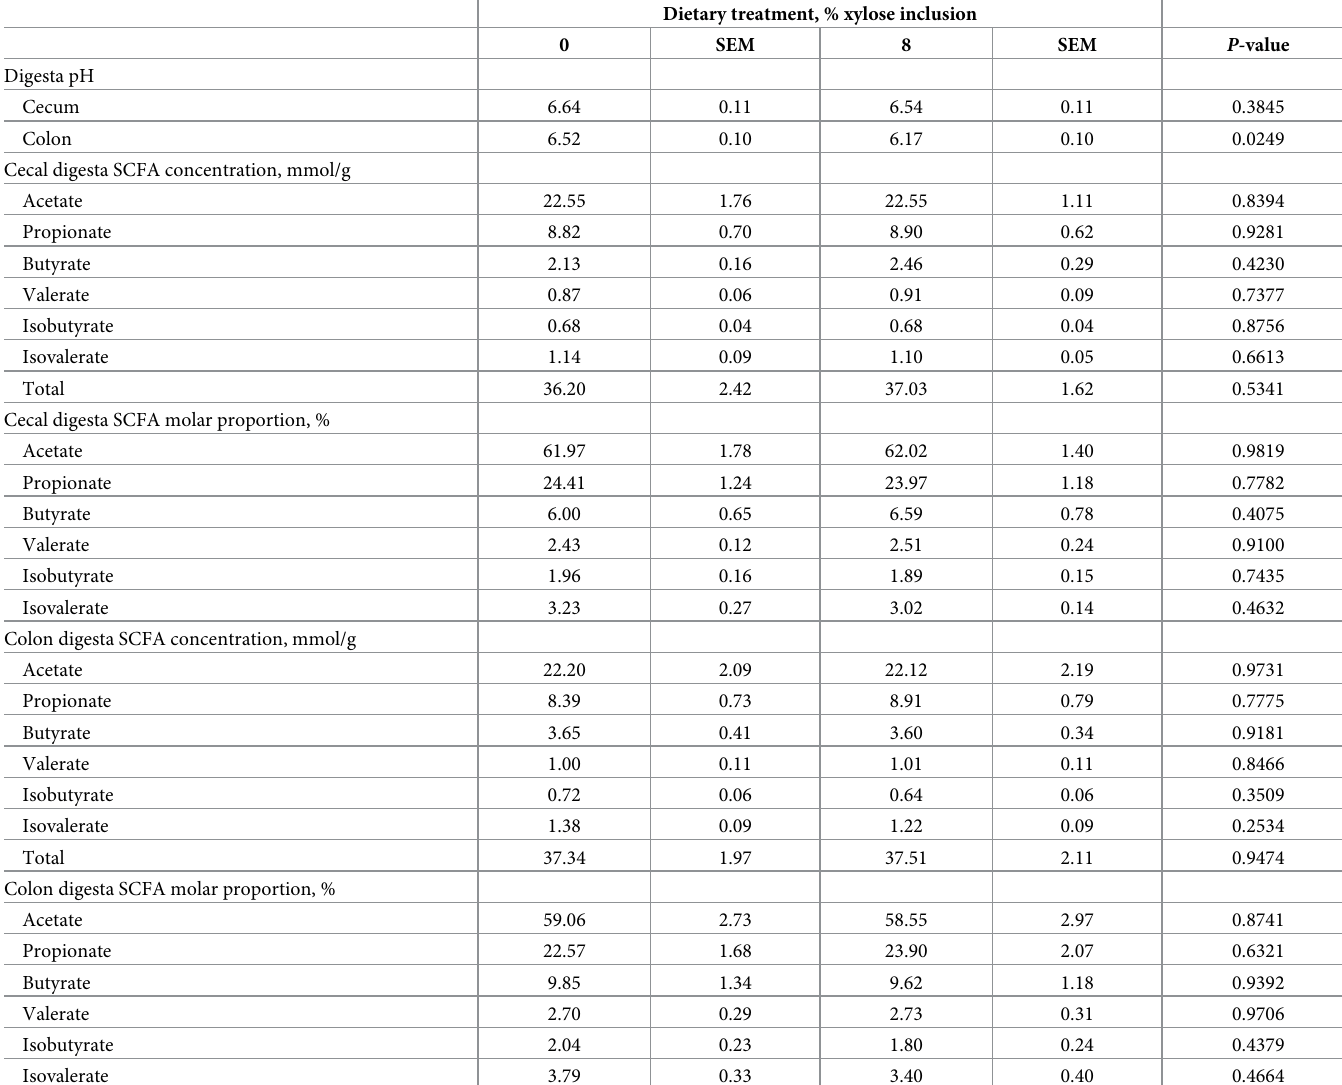
Table 6. Effect of dietary xylose inclusion on cecum and colon digesta pH and SCFA concentration and molar proportions. Dietary treatment, % xylose